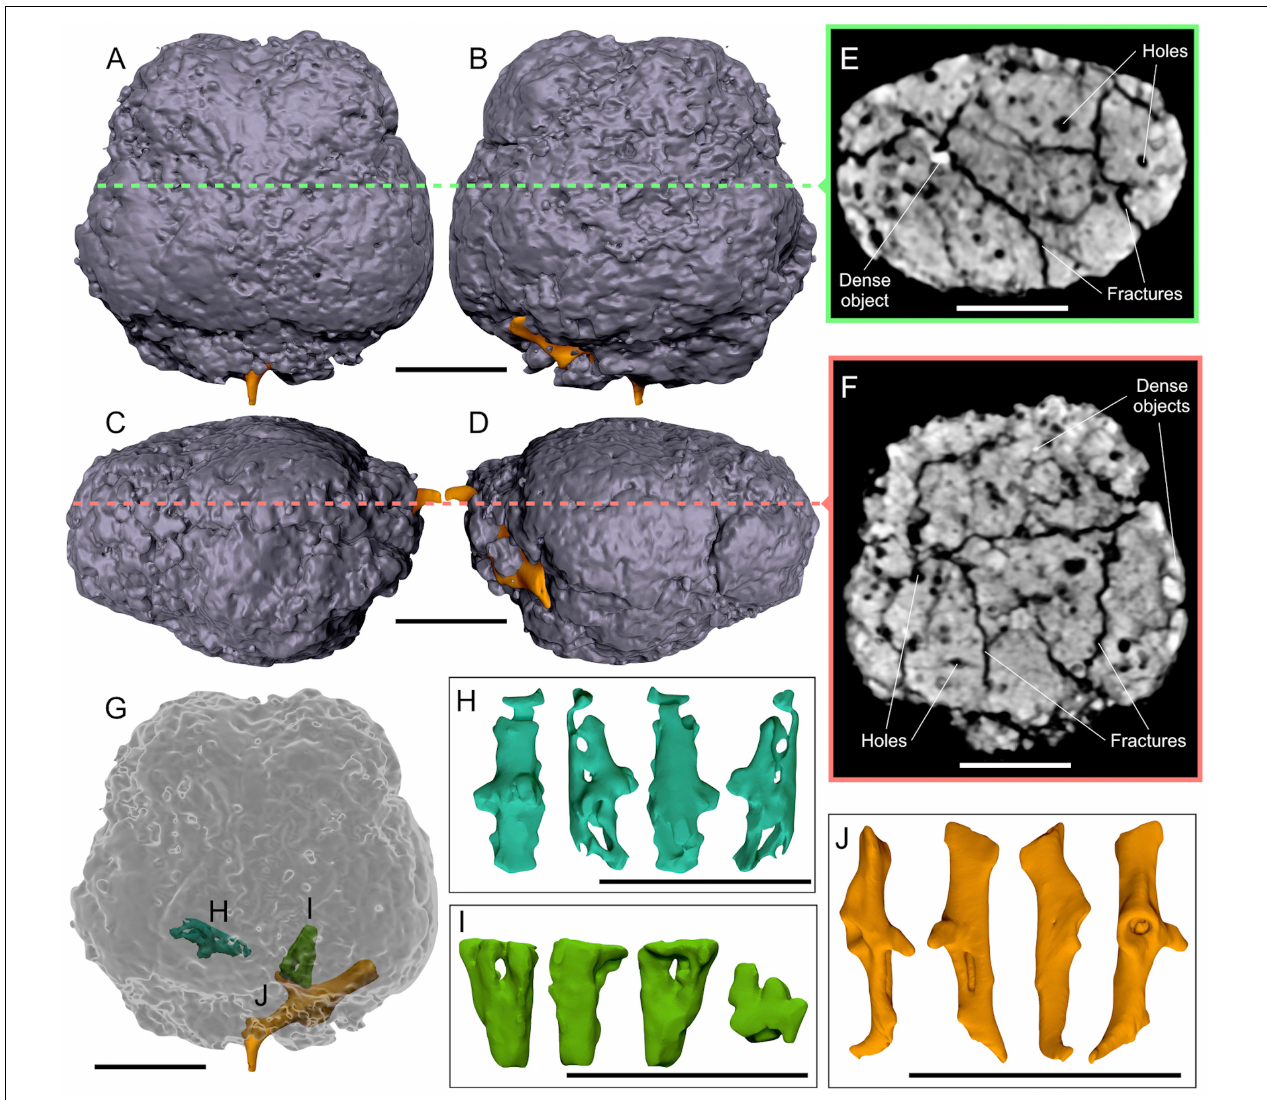
FIGURE 6 | CT images of the natural brain endocast MPND1083. 3D model of the brain in dorsal (A) , ventral (B) , left lateral (C) , and right lateral (D) views. Inner structure of the endocast in coronal (E) and longitudinal (F) sections. Arrangement of the bone fragments embedded within the endocast (G) corresponding to a left calcaneus (H) , a proximal epiphysis of a third right metatarsal (I) , and a right coxal bone (J) of a rabbit. Scale bar 3